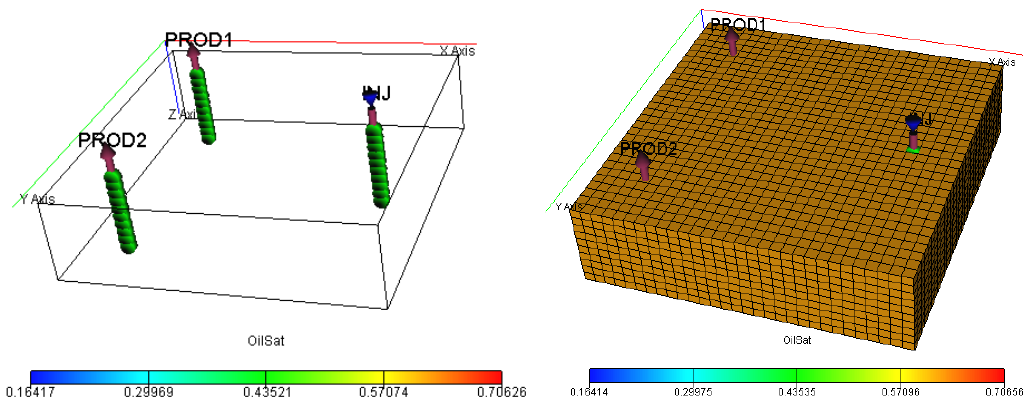
Figure 5. Map view of the location and position of two vertical production wells and one injection well.